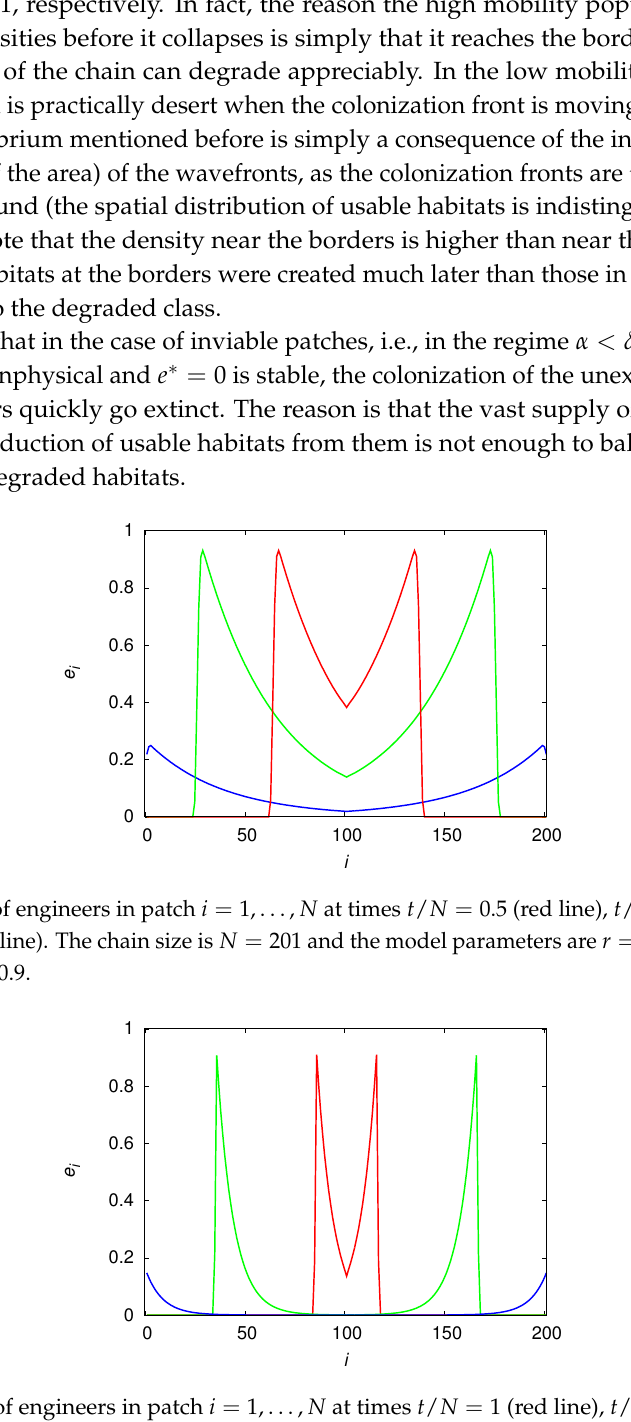
Figure 8. Density of engineers in patch i = 1, . . . , N at times t / N = 1 (red line), t / N = 4 (green line) and t / N = 7 (blue line). The chain size is N = 201 and the model parameters are r = 1, α = 1, δ = 0.01, ρ = 10 − 5 and µ =